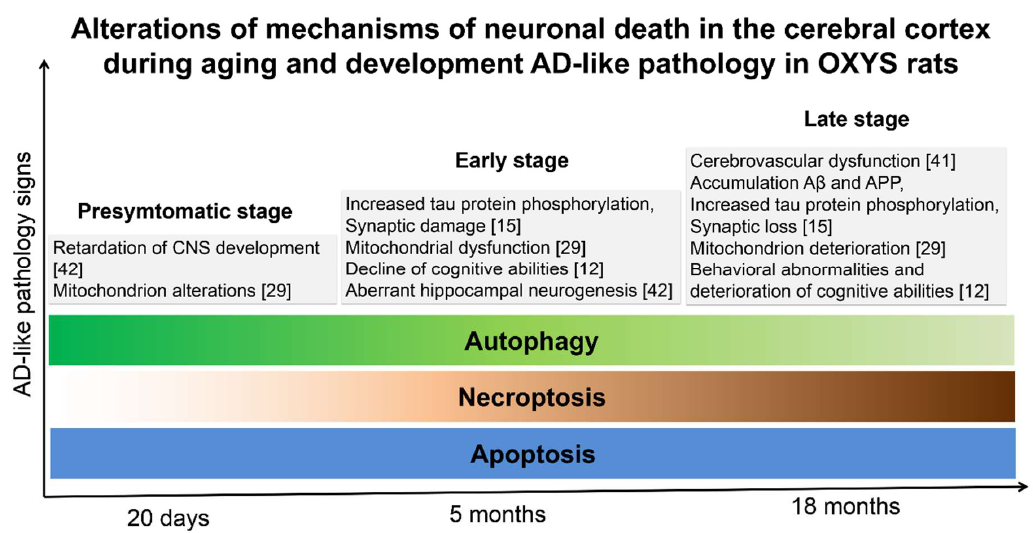
Figure 6. The proposed model of alterations of neuronal cell death mechanisms during the development of the AD-like pathology in OXYS rats. Apoptosis is activated at the pre-symptomatic stage (age 20 days). Progression of the AD-like pathology is accompanied by activation of apoptosis and necroptosis resulting from a decline of proteostasis and of autophagy. Greater color saturation means enhancement of a process.